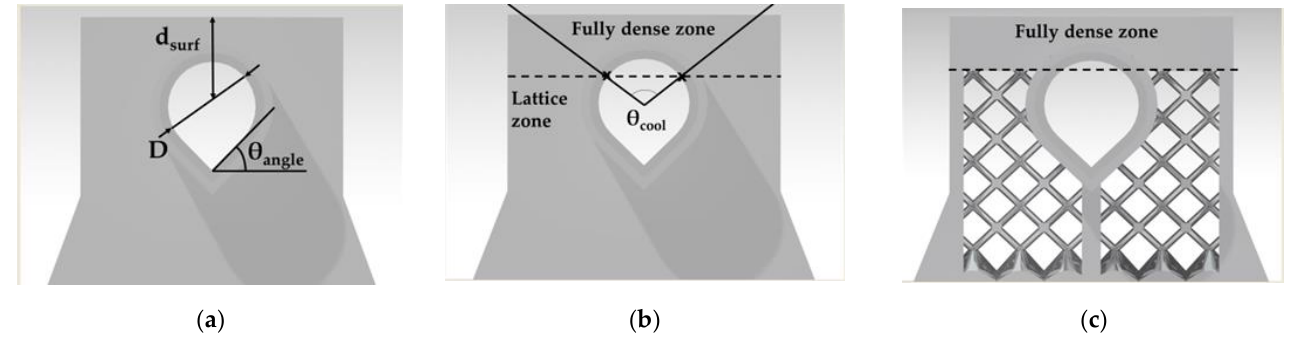
Figure 1. ( a ) Schematic of key design variables; ( b ) graphic representation of segmentation; ( c ) hot stamping die designed with lattice structures.